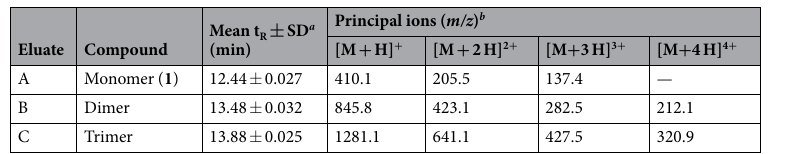
Table 1. Chromatographic and mass spectral data of compounds present in the analyzed mixture. a Chromatographic conditions reported in “Experimental section - Chromatographic separation ”. b Ions detected with Agilent 1100 series MSD single-quadrupole instrument with fragmentation voltage 30 mV, reported in “Experimental section - Preliminary characterization studies ”.